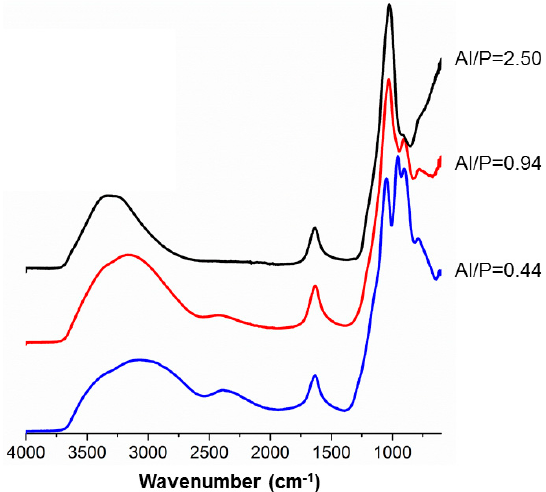
Figure 5. Infrared absorption spectra of MKPC, cured at room temperature, with different Al/P molar ratios, seven days after synthesis.